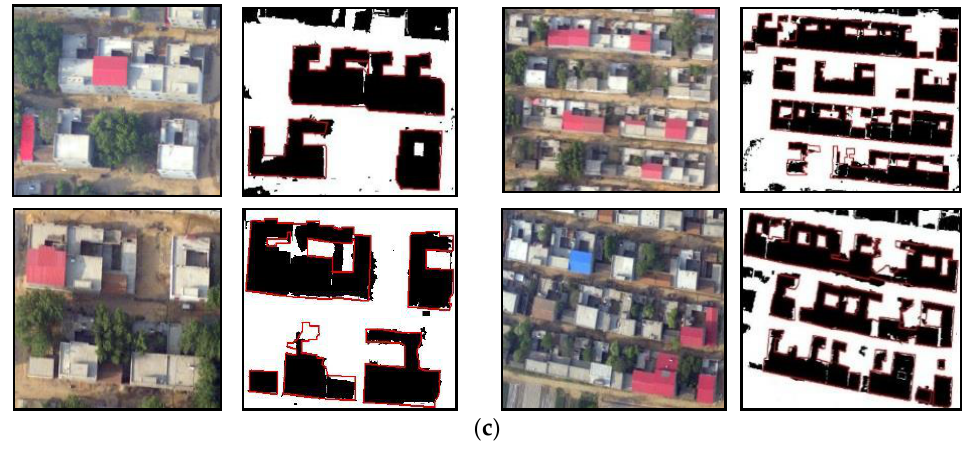
Figure 7. Extraction results of urban and rural areas.